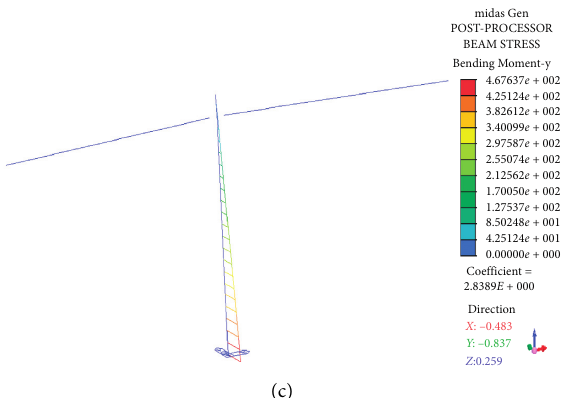
Figure 7: Finite element checking model of railing posts. (a) Element model of a post. (b) Checking results of displacement (post 1). (c) Checking results of stress (post 1).